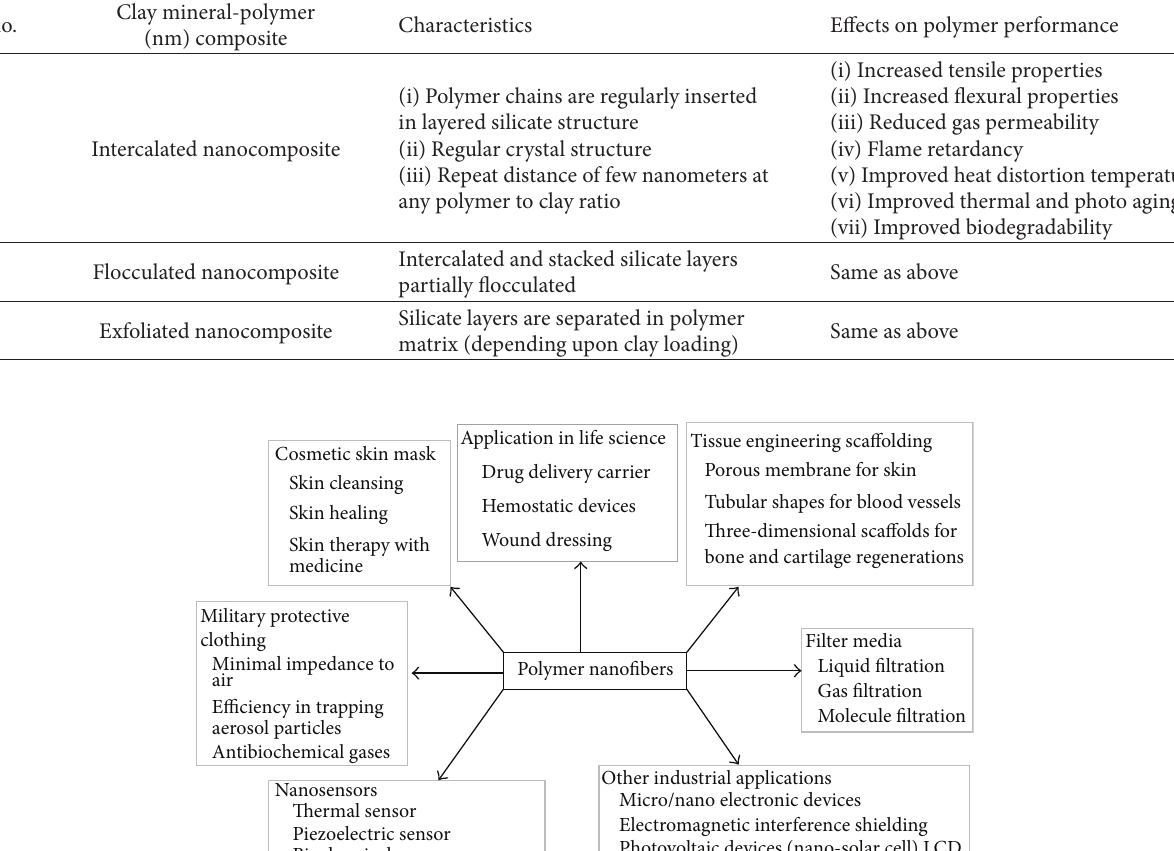
Table 1: Important types of clay mineral-polymer (nm) composite.